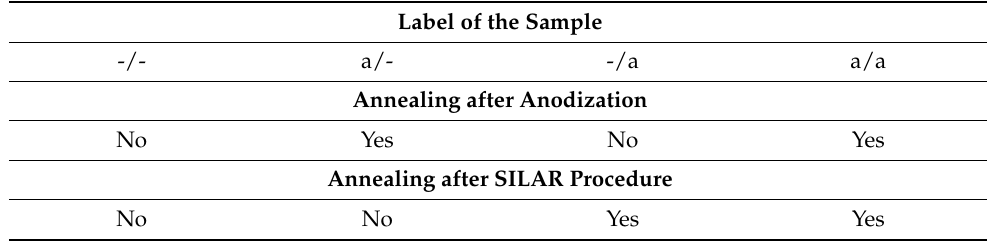
Table 1. Types of SnO x /CdS samples used for detailed studies. Label of the